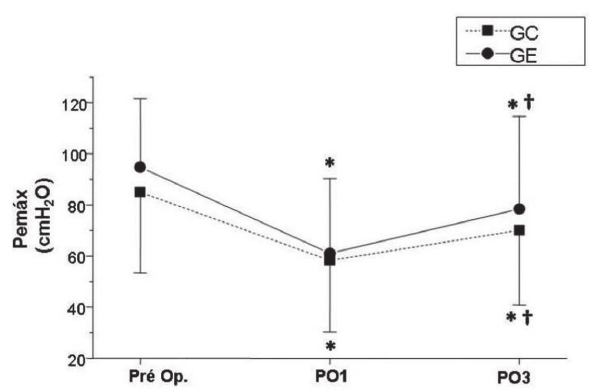
Fig. 2 - Pemáx. Evolução das medidas de Pemáx dos grupos estudados. GC = grupo controle, GE = grupo estudo